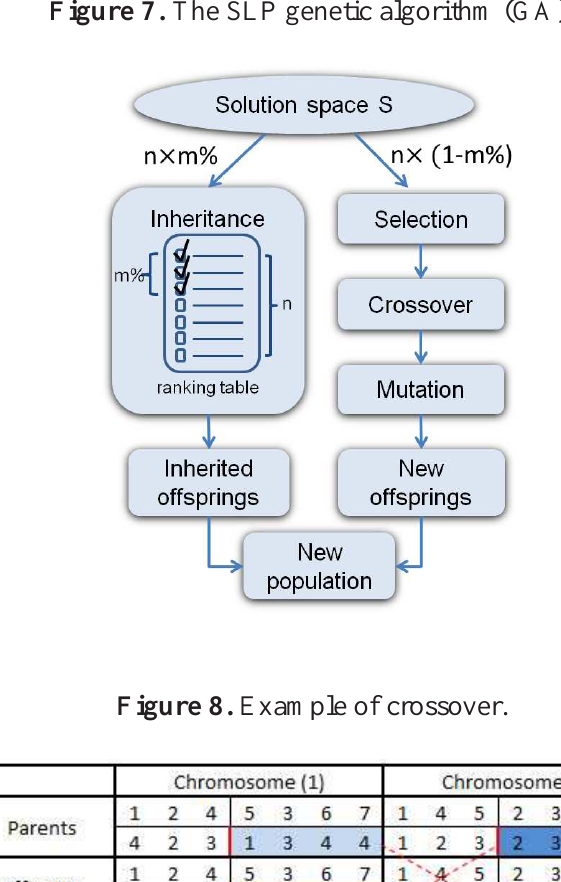
Figure 7. The SLP genetic algorithm (GA).